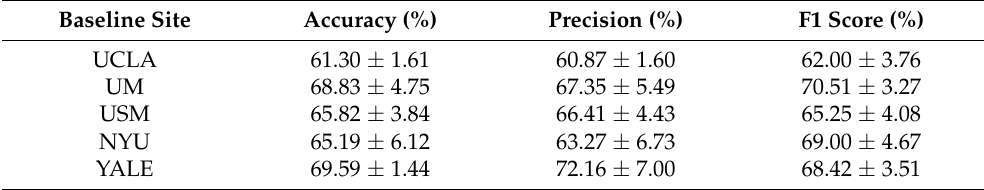
Table 2. The performance on meta-test sets.